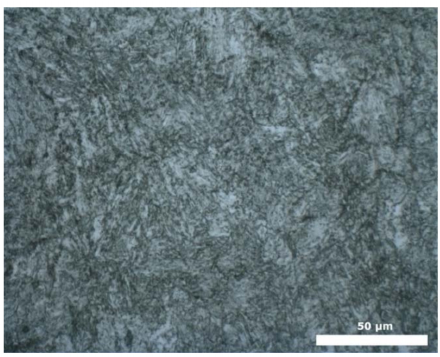
Figure 7. The microstructure of sample A.